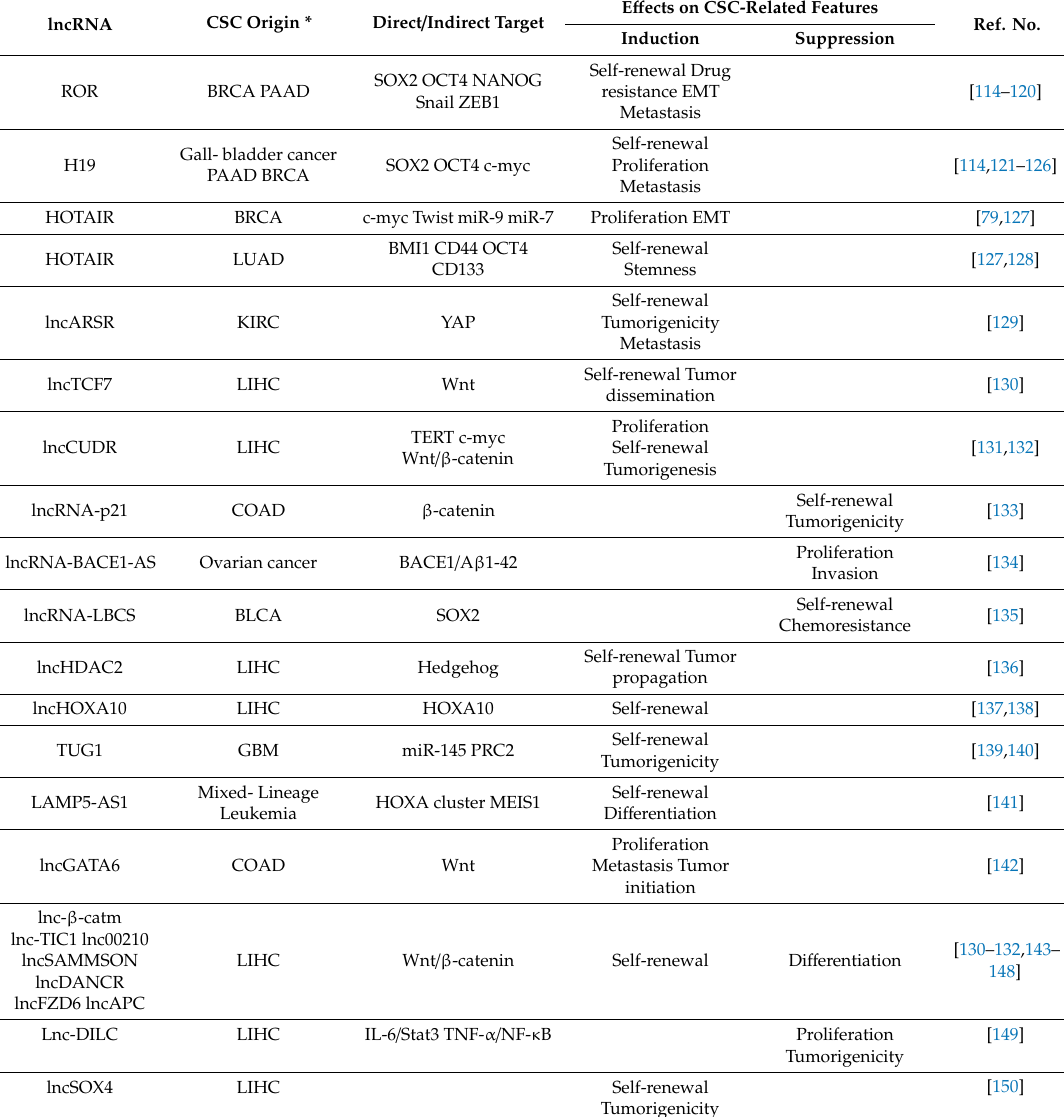
E ff ects on CSC-Related Features